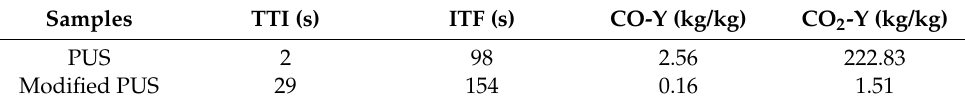
Table 1. Data from cone tests.